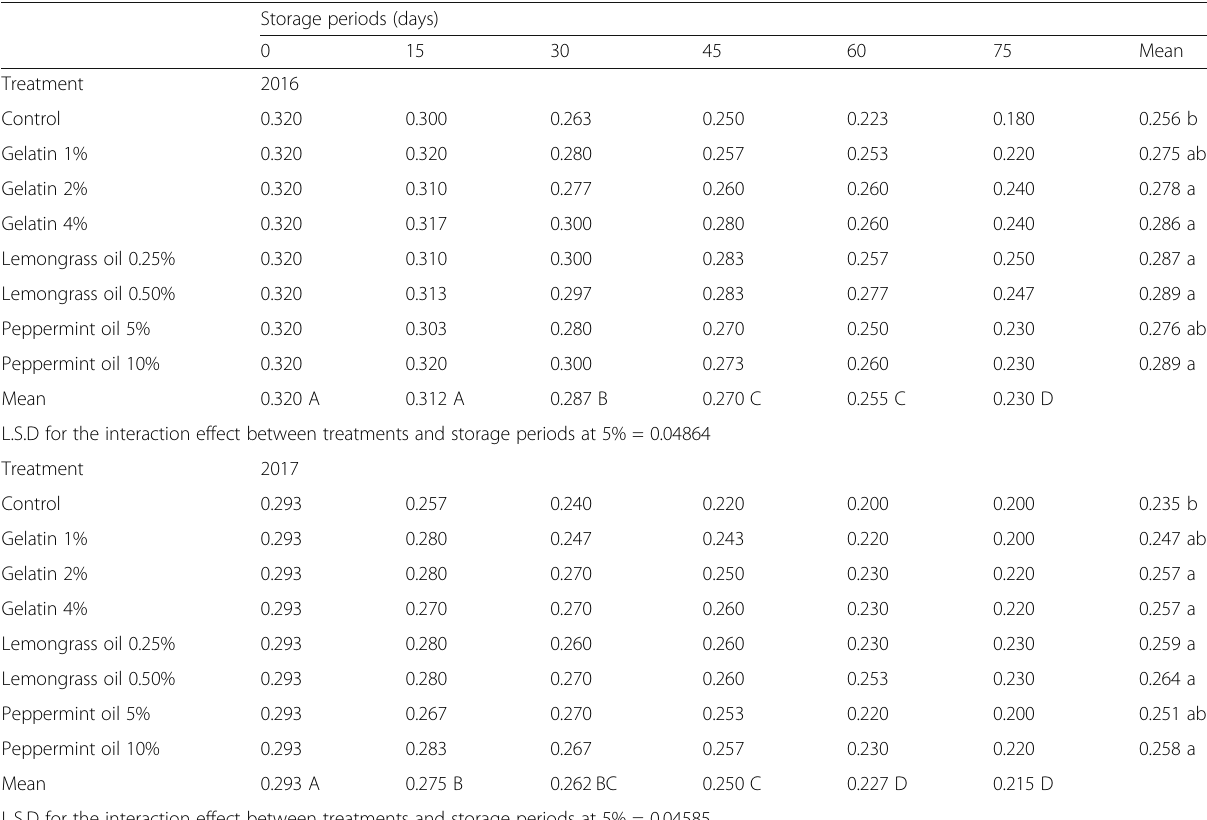
Table 6 Effect of gelatin, lemongrass oil, and peppermint oil on total acidity (%) of Samany date palm fruits stored at 0.0 °C ± 2 during two experimental